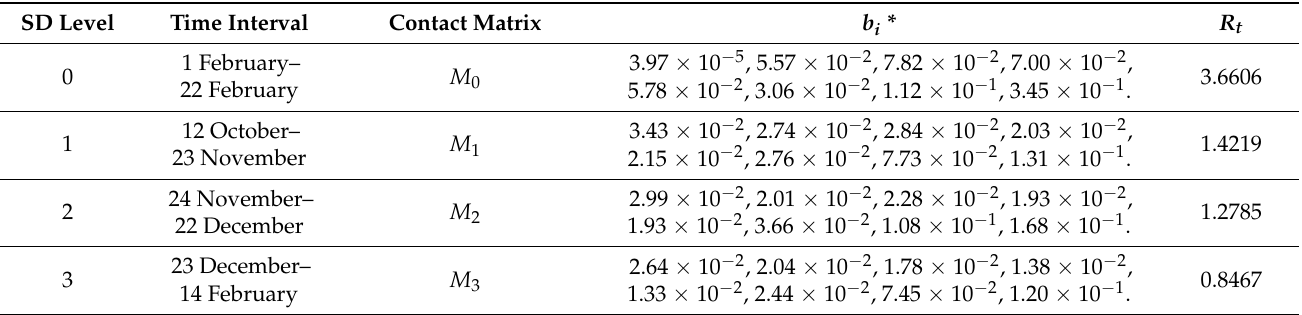
Table 5. Values of infection probability and reproduction number depending on age